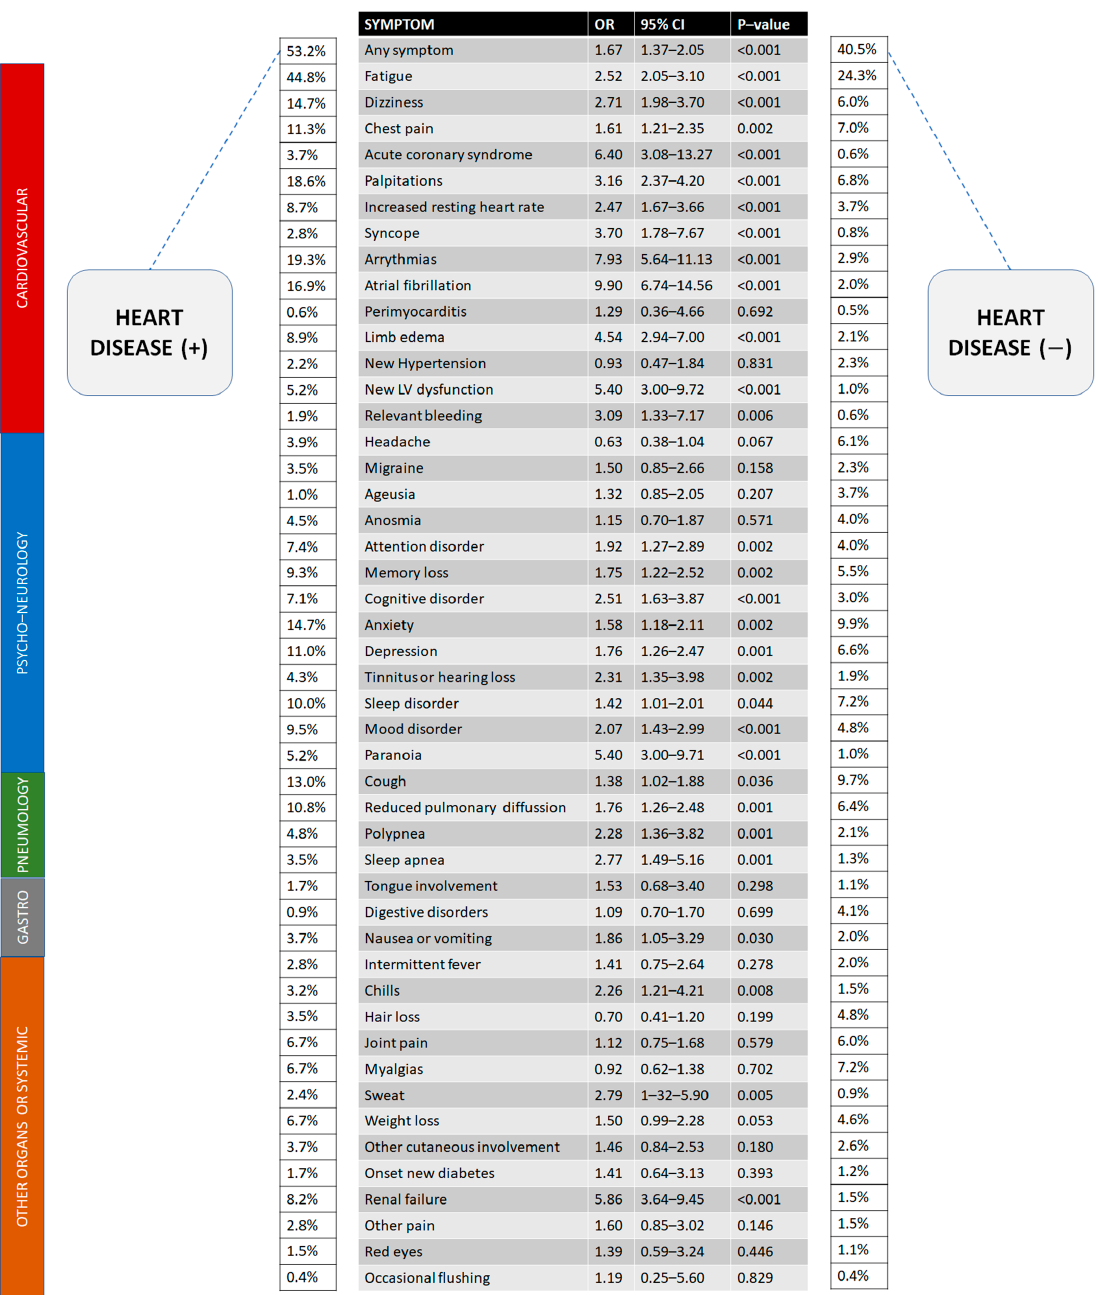
Figure 3. Long-term effects of COVID-19 (post-COVID-19 syndrome) after discharge comparing patients with a heart condition or not (data expressed in percentages over available patients, N = 2651). Risk estimates (OR) are univariate.